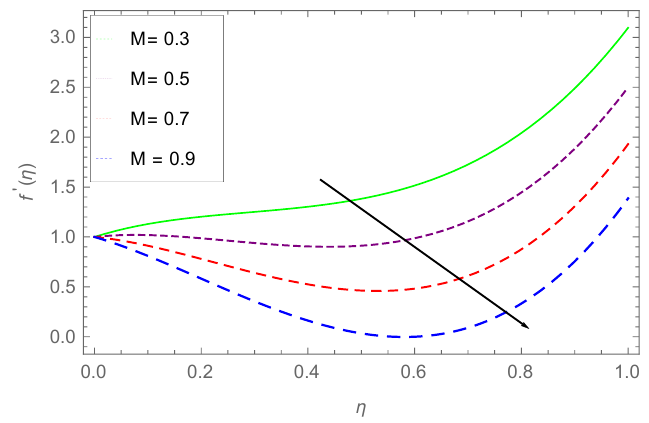
Figure 7. Impact of M on f (cid:48) ( η ) , for γ 1 = 0.2, β = 0.6, St = 0.6, Gr = 0.5, Gm =